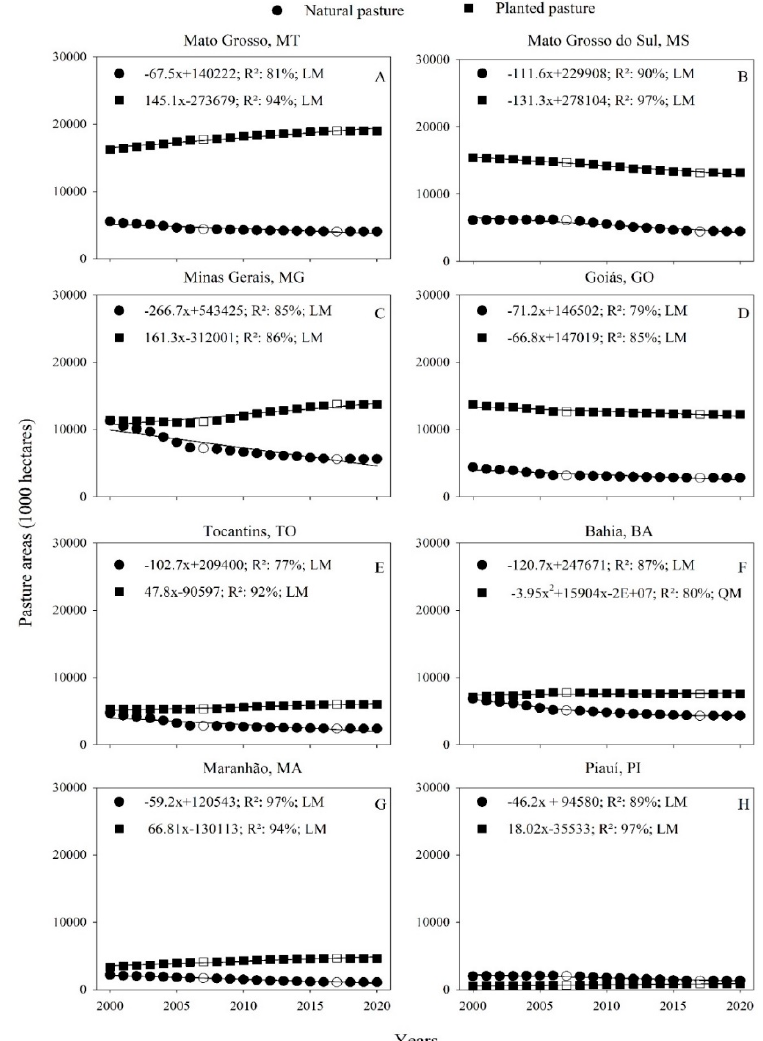
Figure 7. Pasture areas (natural and planted; 1000 hectares) in Mato Grosso (MT), Mato Grosso do Sul (MS), Minas Gerais (MG), Goiás (GO), Tocantins (TO), Bahia (BA), Maranhão (MA), and Piauí (PI) of soybean, corn, coffee, sugarcane, and cotton from 2000 to 2020. LM and QM: linear and quadratic models. Data of 2006 and 2017 (white color) were not modeled.